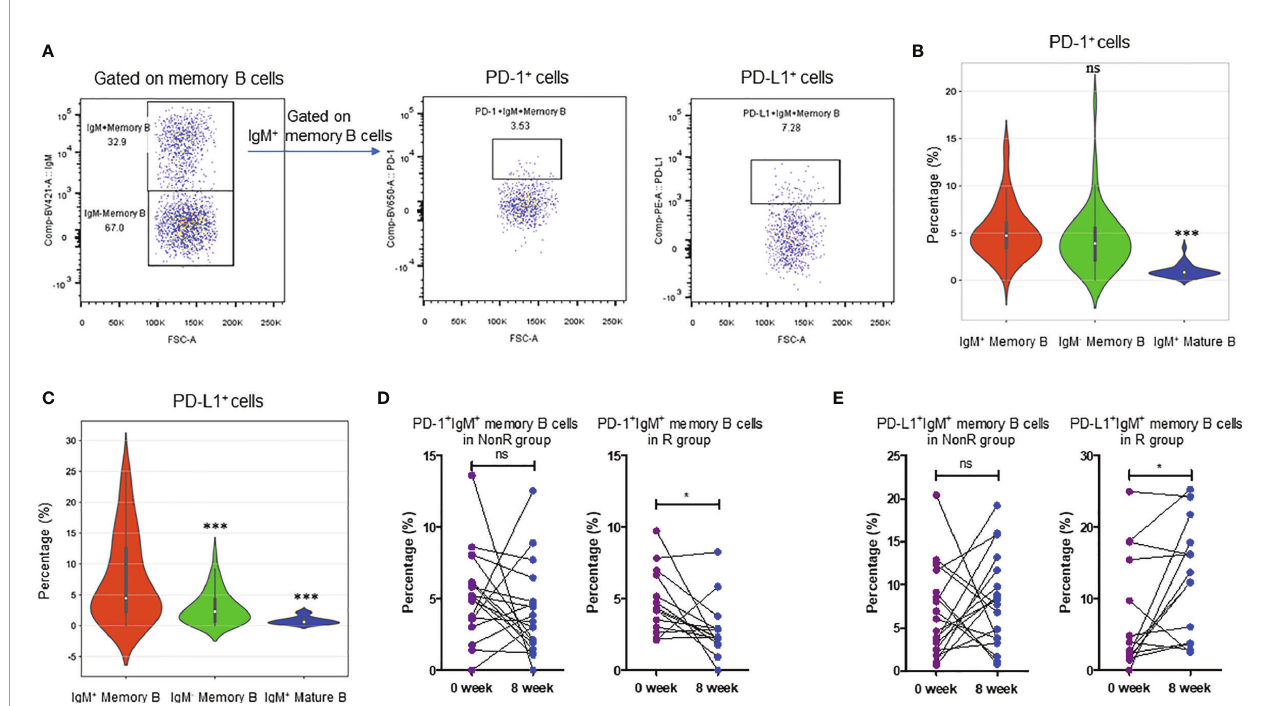
FIGURE 5 | Dynamics of peripheral PD-1 and PD-L1-expressing IgM + memory B cells in R and NonR patients receiving anti-PD-1monotherapy. (A) Gating strategy for PD-1 + and PD-L1 + cells in IgM + memory B cells by fl ow cytometry. (B) Comparisons of PD-1 expressions on IgM + memory B cells, IgM - memory B cells and IgM + mature cells. (C) Comparisons of PD-L1 expressions on IgM + memory B cells, IgM - memory B cells and IgM + mature cells. (D, E) Dynamics of the percentages of PD-1 + IgM + memory B cells (D) and PD-L1 + IgM + memory B cells (E) at the baseline and 8 weeks after nivolumab treatment in R (n = 14) and NonR (n = 18) patients. The paired- Student t test was used to analyze the differences between two groups as well as in baseline and after the treatment. *** P < 0.001, * P < 0.05, ns, P >